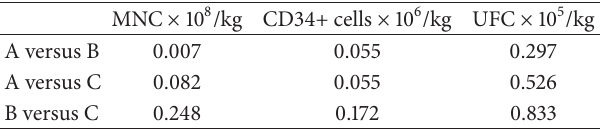
Table 3: Statistical analysis using the nonparametrical Kruskal- Wallis